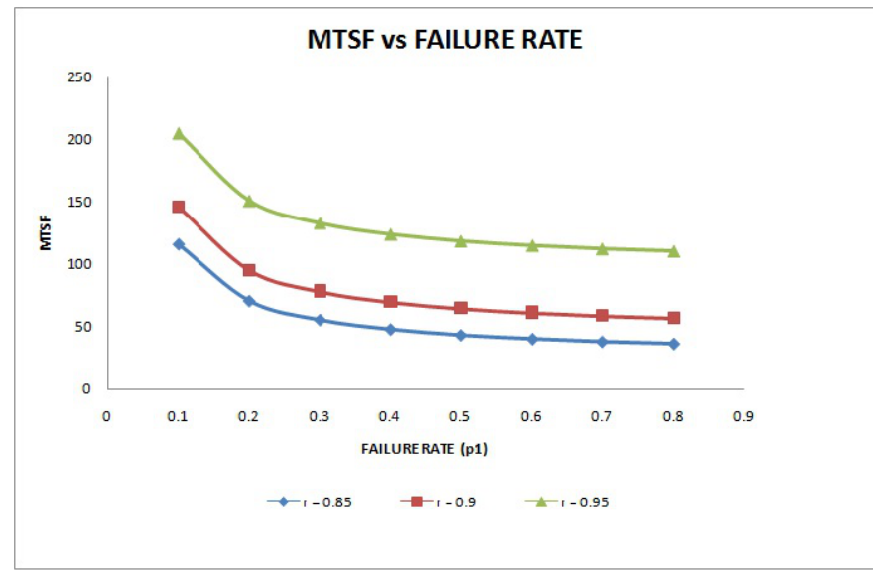
Fig. 2. MTSF vs failure rate